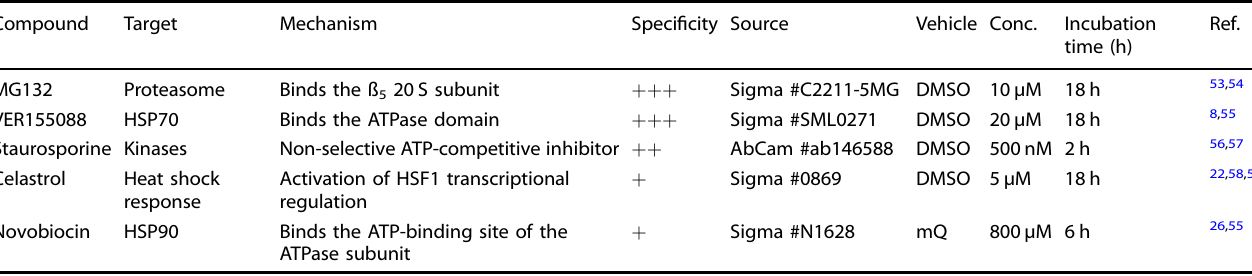
Table 1. Pharmacological